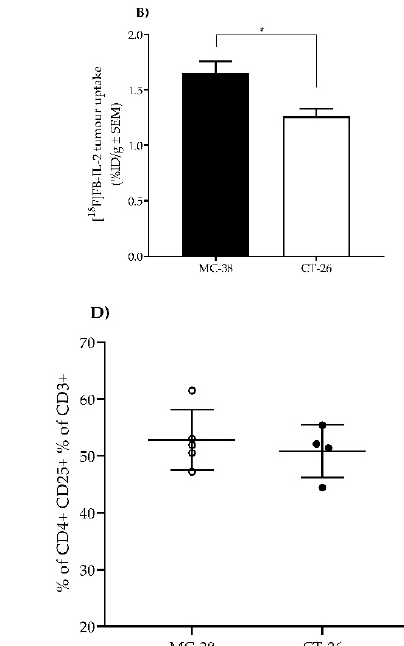
Figure 4. In vivo PET imaging of [ 18 F]FB-IL-2 in naïve Balb/c mice. ( A ) Whole-body PET-CT fused image represents the summed frames from 40–60 min post-injection. ( B ) Dynamic PET time–activity curves showing initial uptake followed by washout of [ 18 F]FB-IL-2 tracer in most of the major organs. ( C ) Ex vivo biodistribution data (70 min post-injection) showing [ 18 F]FB-IL-2 tracer accumulation in different organs confirming PET-based biodistribution.